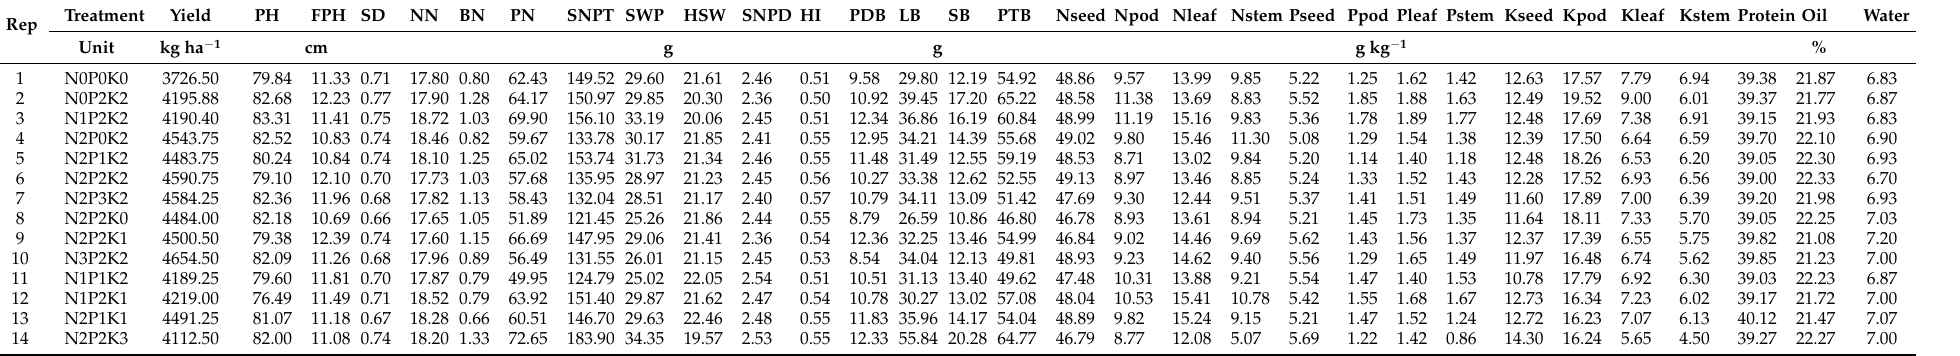
Table 2. The average result for 3414 experiment